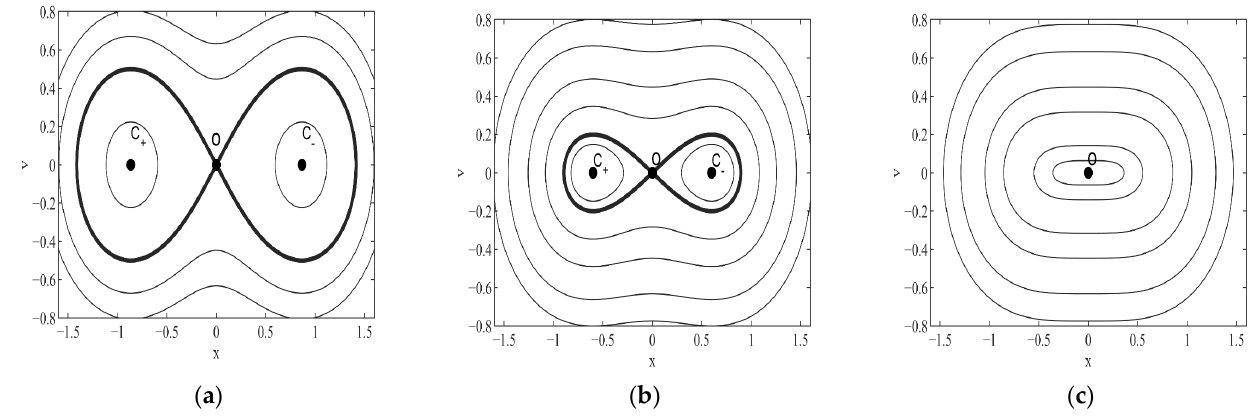
Figure 3. Phase portraits of the unperturbed system (5) for di ff erent values of α : ( a ) α = 0.5; ( b ) α = 0.8; and ( c ) α = 1.